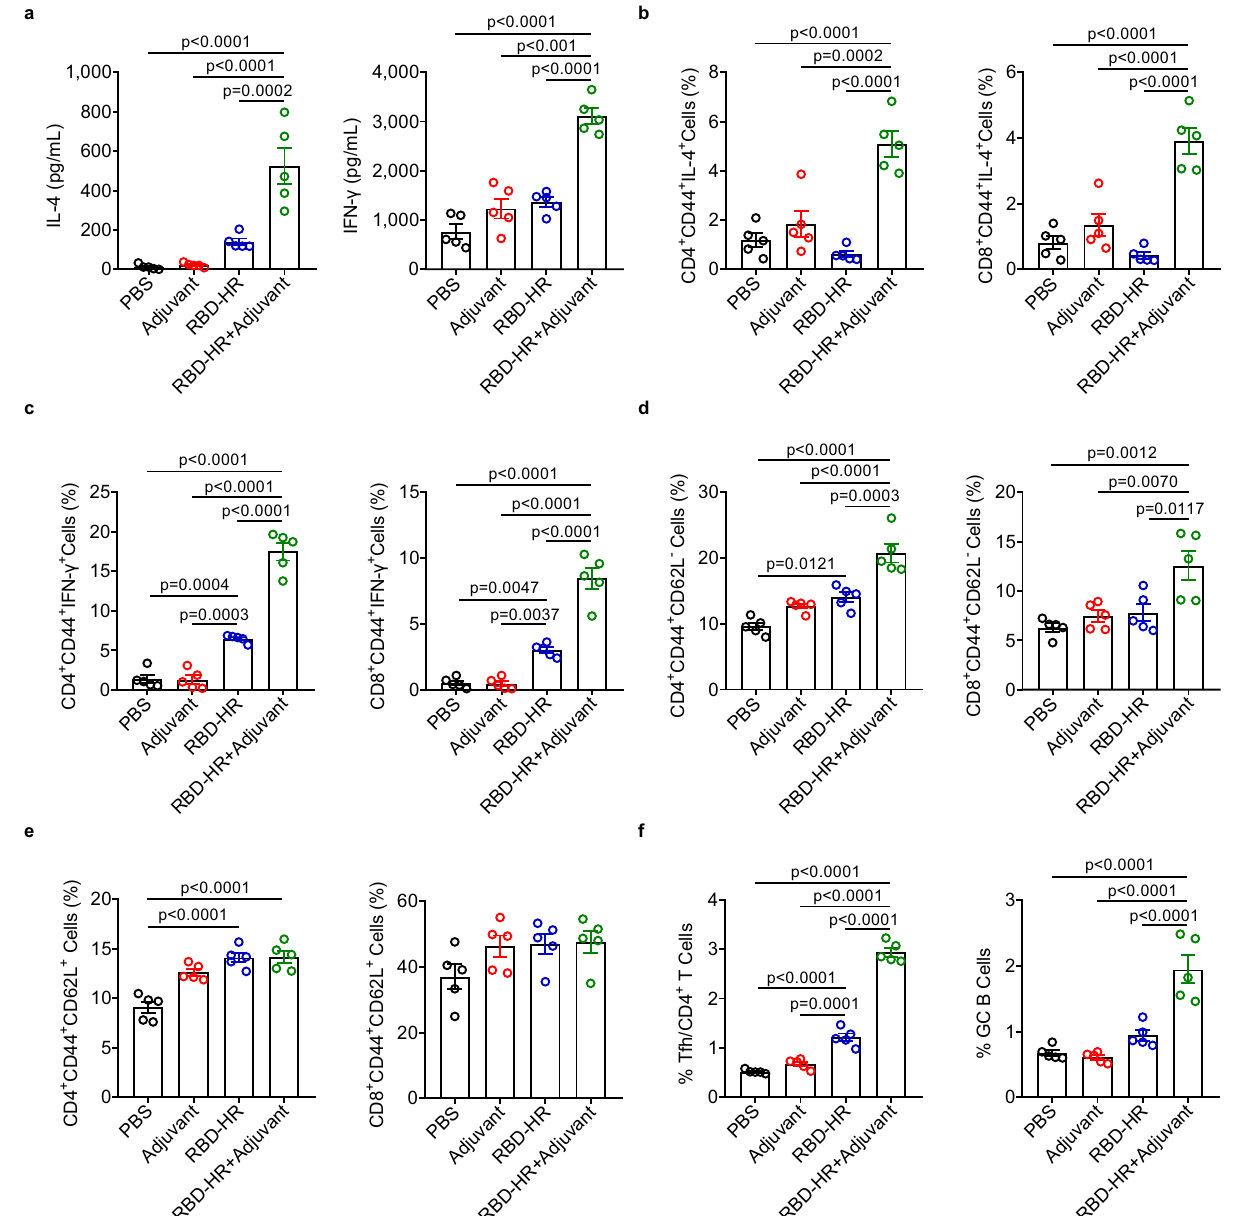
Fig. 4| RBD-HR/trimervaccineinduced strongT cellimmuneresponseinvivo. a The levels of IFN- γ and IL-4 in the supernatants of spleen lymphocytes from immunized mice were detected by ELISAafter stimulation with RBD (10 μ g/ml) for threedays. b , c ThenumberofRBD-speci fi cIL-4orINF- γ -producingmemoryTcells in spleen were analyzed by fl ow cytometry after stimulation with RBD. Memory T cells were gated on CD44 high B220 − MHC-II − CD4 + or CD8 + . d The percentage of effectormemory(CD44 + CD62L − )ofCD4orCD8Tcellsinspleen. e Thepercentage ofcentralmemory(CD44 + CD62L + )ofCD4orCD8Tcellsinspleen. f Thefrequency